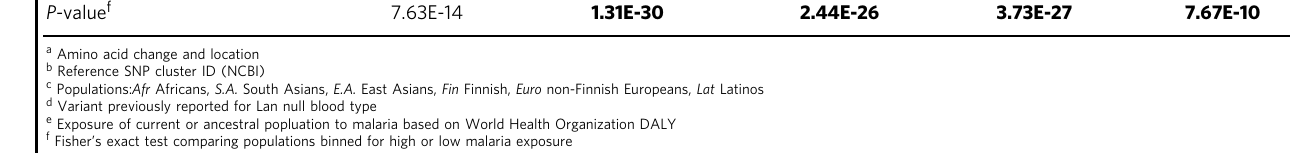
Table 1. All other relevant data are available from the authors upon request.